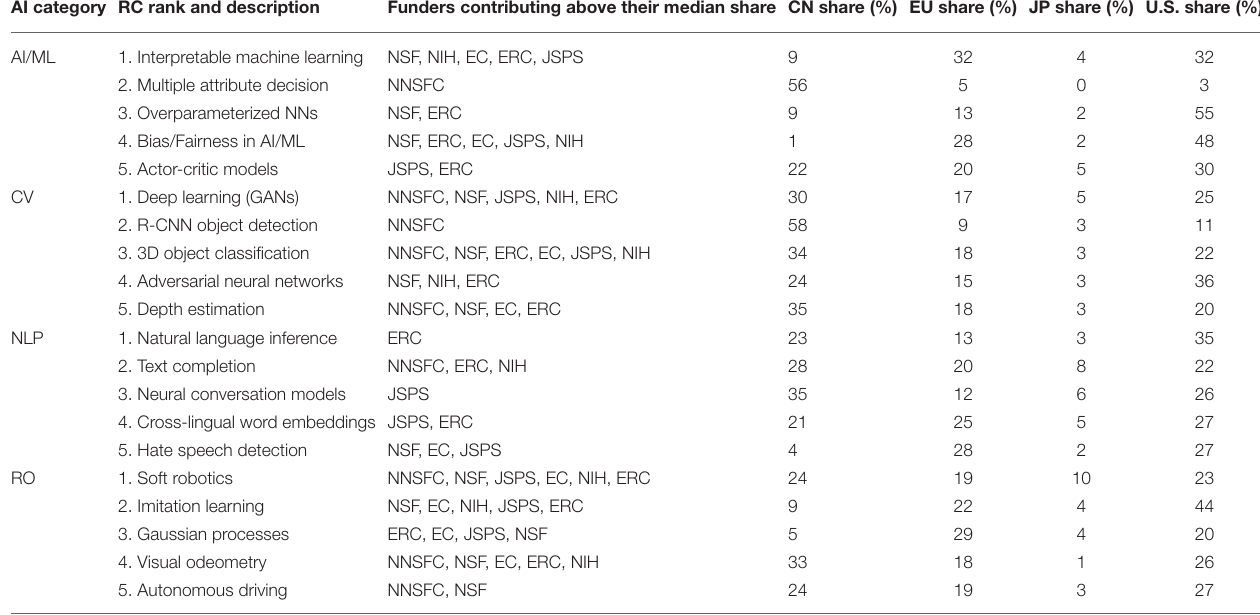
TABLE 6 | Top five extreme growth research clusters for each category of AI. AI category RC rank and